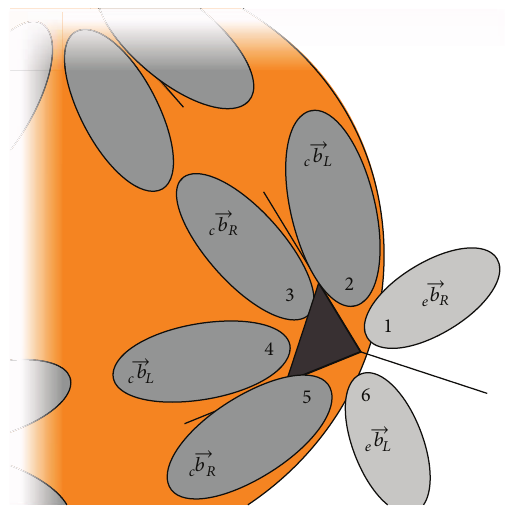
Figure 14: Average SNR (dB) over distance from base stations. Average over results at 16 BSs. The dashed lines show a linear